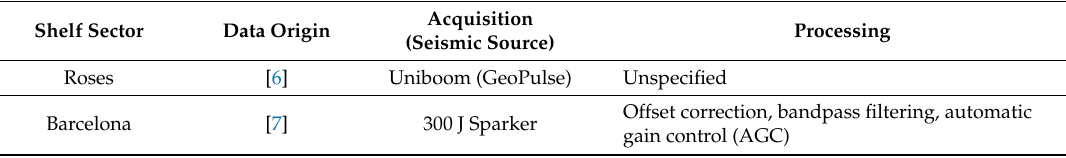
Table 1. Summary of acquisition and processing parameters used in the different seismic data presented in this